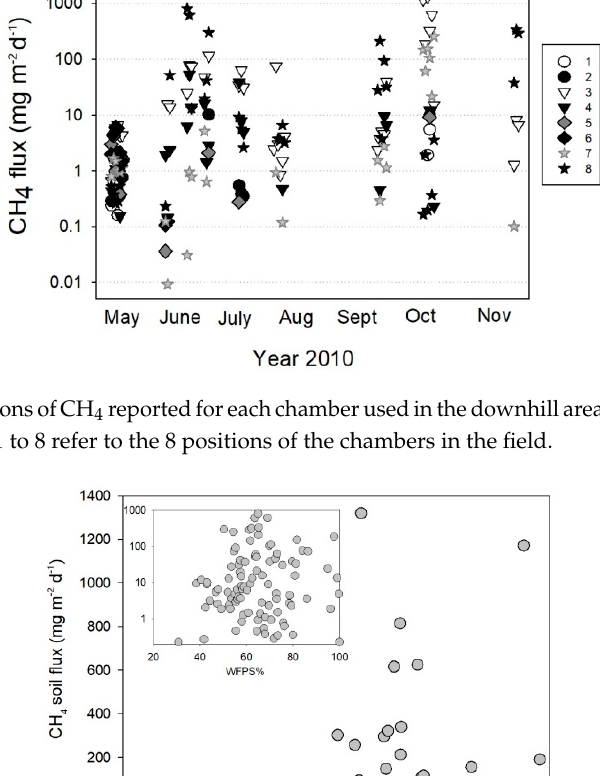
Figure 5. Net emissions of CH 4 reported for each chamber used in the downhill area. Symbols numbered in the legend from 1 to 8 refer to the 8 positions of the chambers in the field.